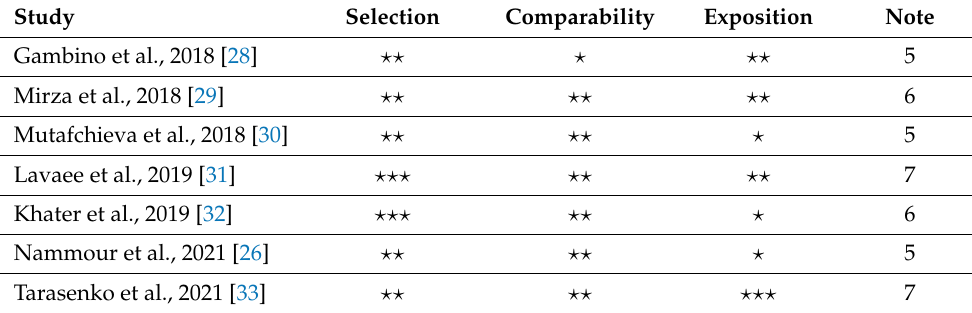
Table 2. Quality evaluation: the Newcastle–Ottawa Scale [27].